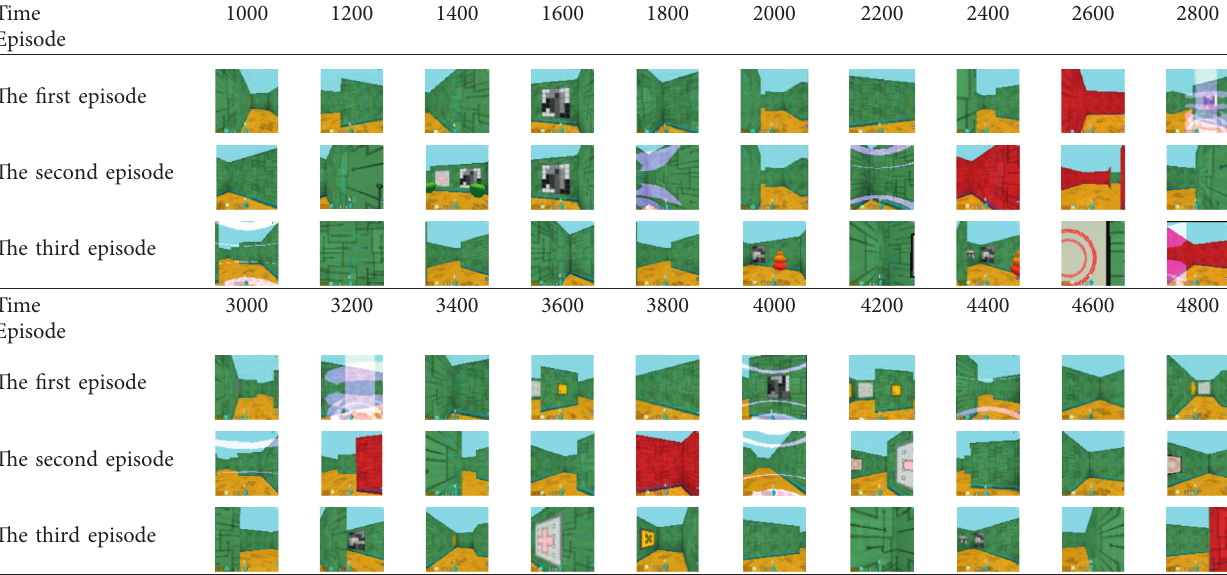
Table 3: The states that the artificial agent sees in stairway_to_melon